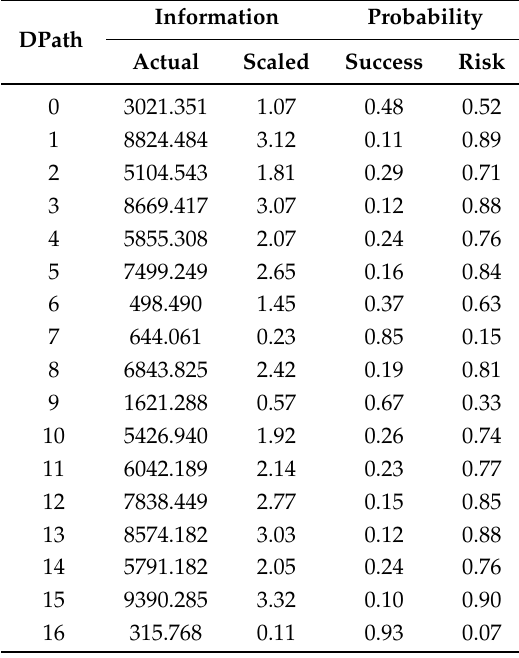
Table 5. An example of large DPath information values scaled for probability